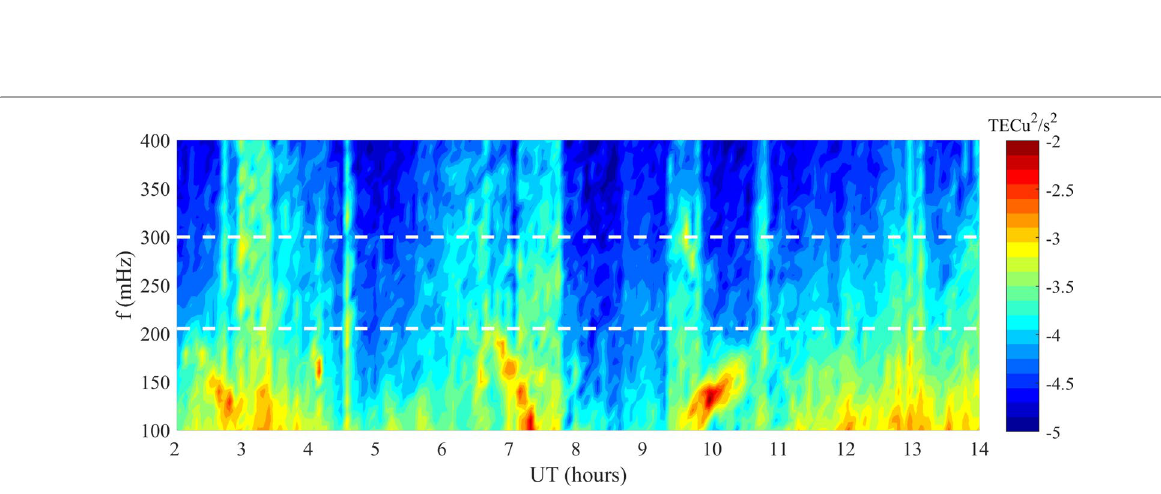
Fig. 8 The dynamical spectrum of 1-s resolution ROT time series between 0200 and 1400 UT on 22 February 2007. Dashed white lines indicate the frequency interval of